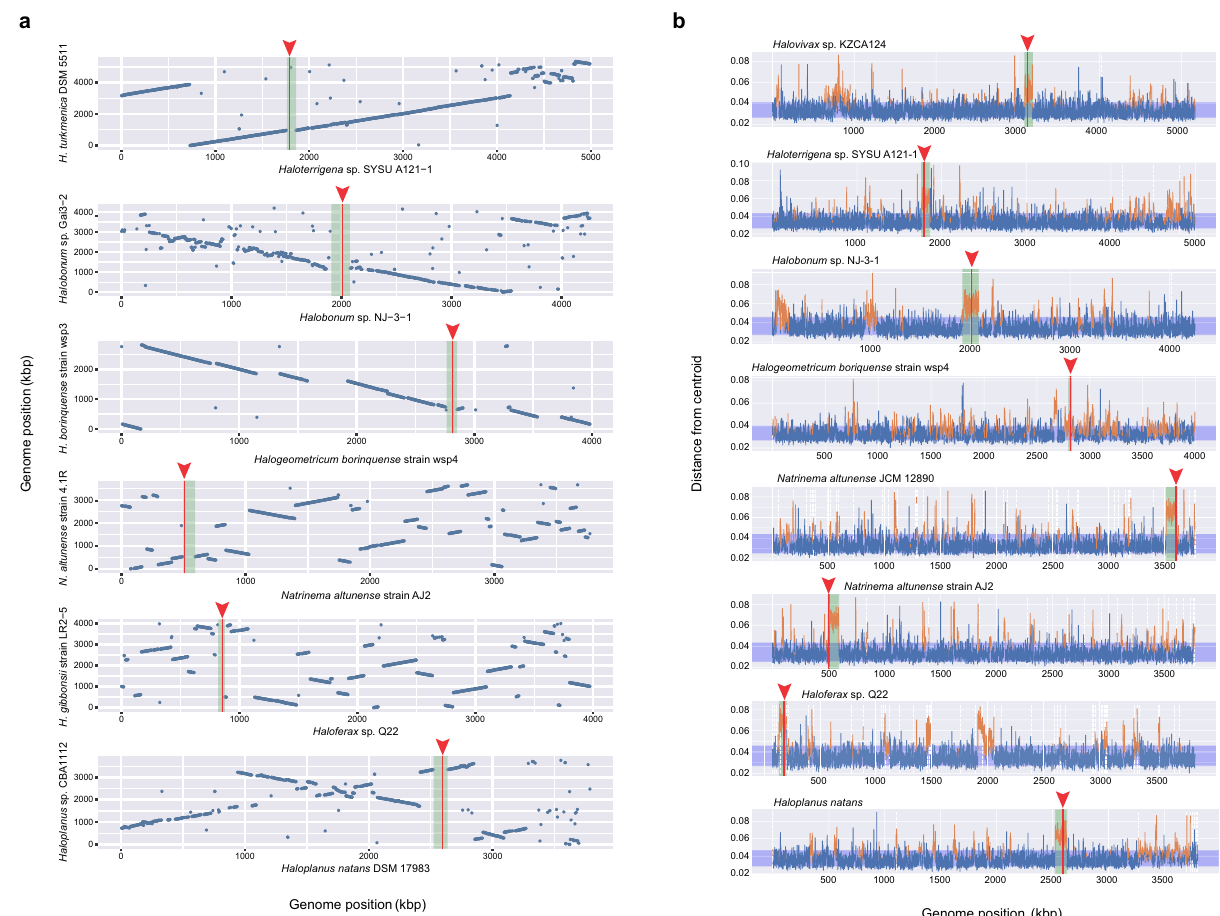
Fig. 7 Genomic features of Fsx1s. a Whole genome comparison of species with and without fsx1 . Each blue dot represents a segment of 500 bp with more than 80% identity between the species harboring fsx1 (e.g., Haloplanus natans DSM 17083) and the species with no fsx1 (e.g., Haloplanus sp. CBA1112, see Supplementary Table 4). Species with fsx1 are in the x -axis, the base of the green rectangles represent the detected IME carrying the fsx1 gene, locus of fsx1 is in red vertical line and pointed with a red arrowhead. b K-mer spectra deviation of fsx1 -containing IMEs. K-mer spectrum deviation from centroid is shown for each of the Pure Culture Genomes (PCGs) where fsx1 was detected. Blue region shows the standard deviation. Locus of fsx1 is in red vertical line and pointed with a red arrowhead, the mobile element containing fsx1 is in green. Dashed vertical white lines indicate the end of a contig in the genome assembly. fsx1 is consistently found within regions that deviate from the core genome ’ s spectrum, indicating they belong to a mobile element. Kbp, kilo base